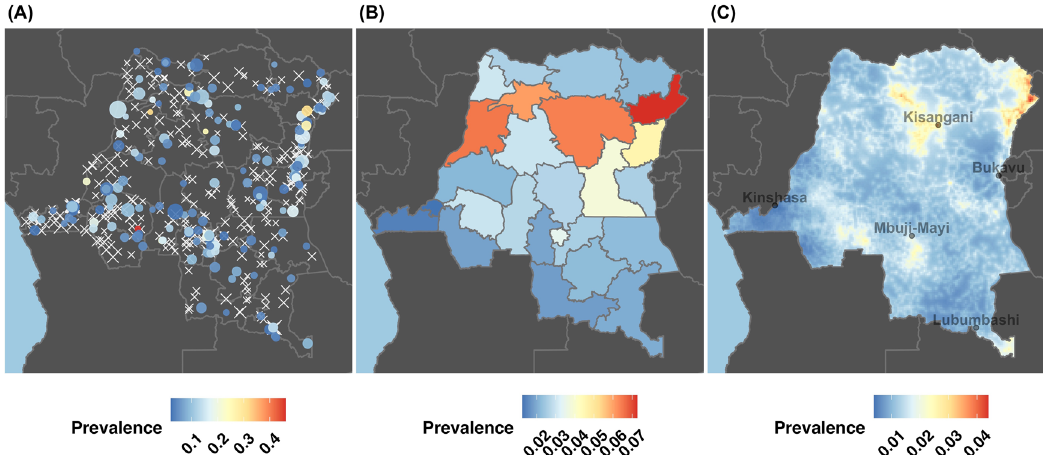
Fig. 4 The distribution of P. vivax infections across the Democratic Republic of the Congo. For each map, the prevalence (as a proportion) is indicated along a blue – red spectrum (prevalence ranges and color scales differ between A – C ). A Each cluster that contained a P. vivax infection is indicated along the blue – red prevalence spectrum, while clusters that lacked P. vivax infections are indicated with white X-marks. The scale of the cluster-mark re fl ects